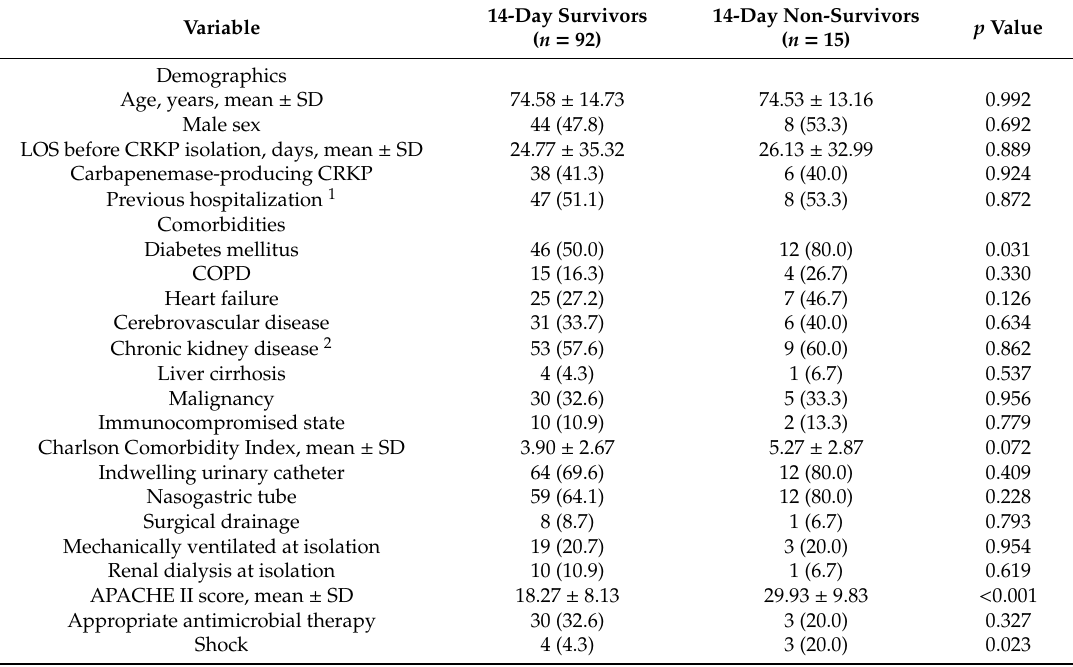
Table 3. Univariate and multivariate Cox regression analysis of risk factors for 14-day mortality among patients with CRKP bacteriuria.